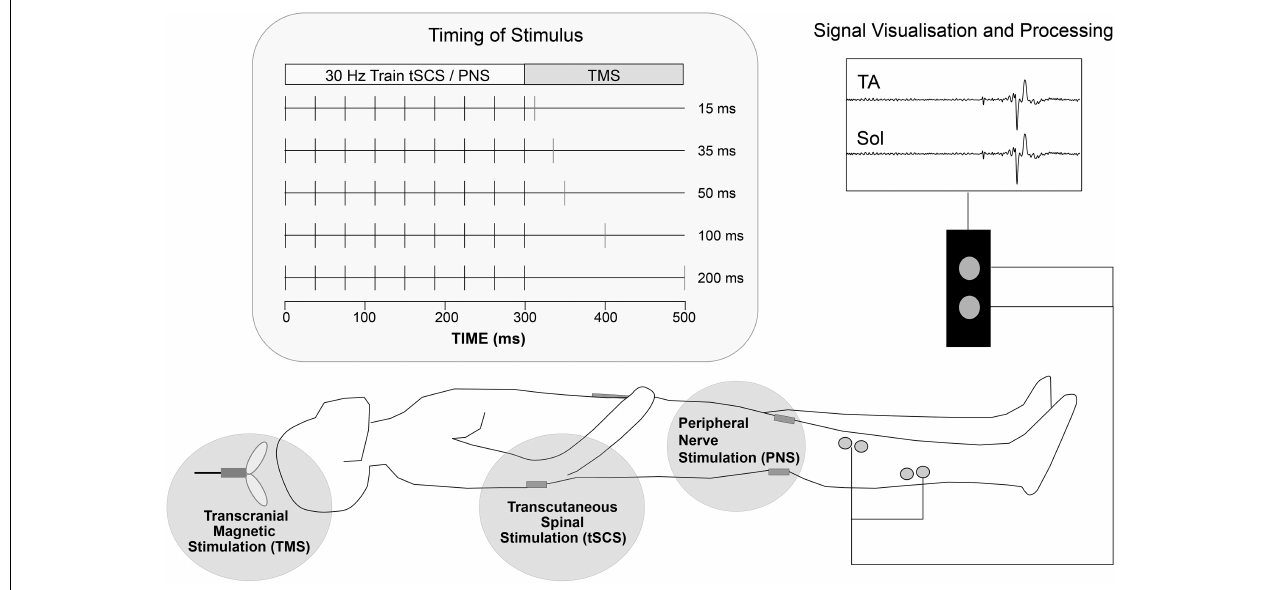
FIGURE 2 | Schematic representation of experiments 2&3 setup. Transcutaneous stimulating electrodes were placed paravertebral at landmarks over T12/L1 to L3/4 spinous processes (tSCS) and the popliteal fossa (PNS). TMS was delivered over the motor cortex region for lower limb at various interstimulus intervals following tSCS or PNS to participants in the supine position. Pairs of surface EMG electrodes were placed over tibialis anterior (TA) and soleus (Sol) muscle groups and MEP activity was